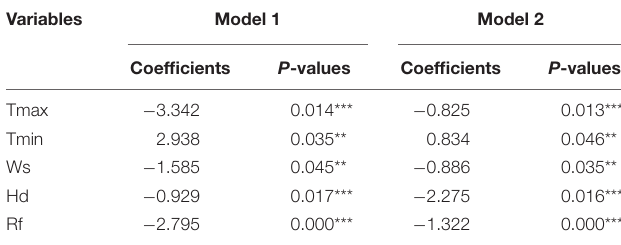
TABLE 5 | Long-run